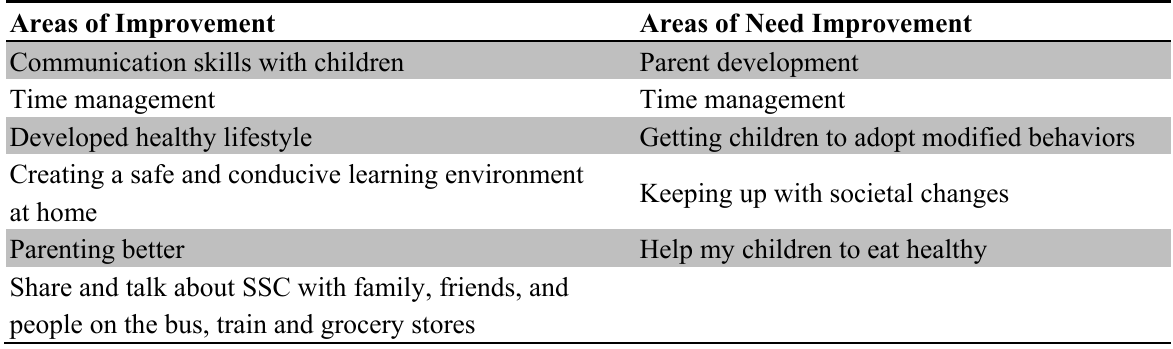
Table 3. Summary of Leadership Skills in Parent: After Completing the SSC